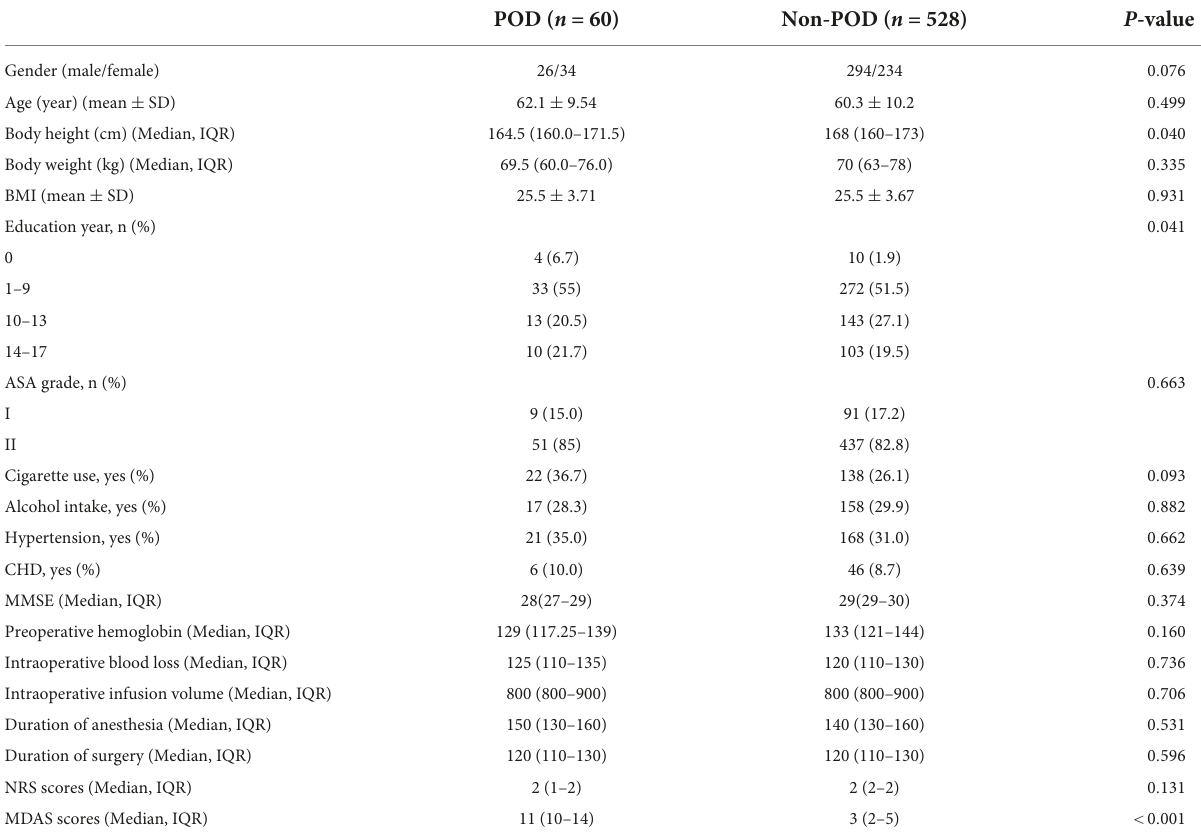
TABLE 1 Characteristics of participants.